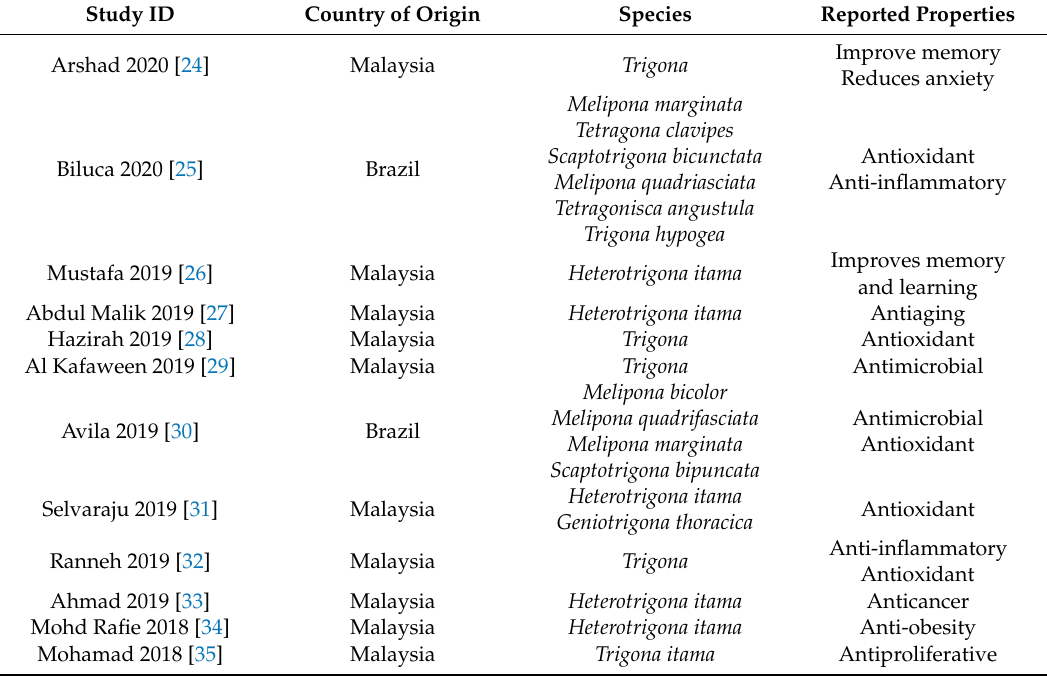
Table 1. List of studies on the potential medicinal properties of stingless bee honey